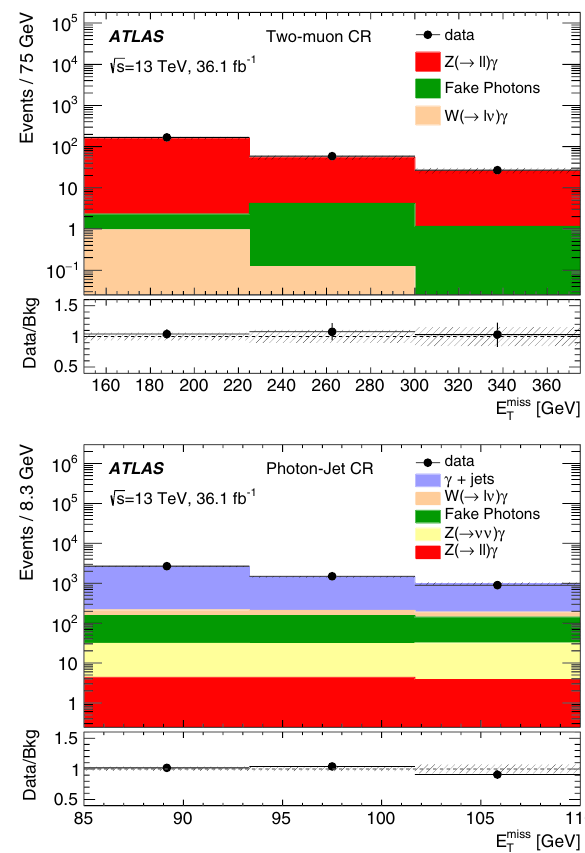
Fig. 2 Distribution of E miss bin fit. For 1muCR, 2muCR and 2eleCR, overflows are included in the in data and for the expected total back- T third bin. The error bars are statistical, and the dashed band includes ground in the CRs: 1muCR ( top left ), 2muCR ( top right ), 2eleCR ( bot- tomleft )andPhJetCR( bottomright ).In1muCRand2muCR,themuons statistical and systematic uncertainties determined by the multiple-bin fit. The lower panel shows the ratio of data to expected background are treated as non-interacting particles in the E miss reconstruction; the T event yields electrons are handled similarly in 2eleCR. The total background expec- tation is normalised using the scale factors k (cid:7) derived from the multiple-